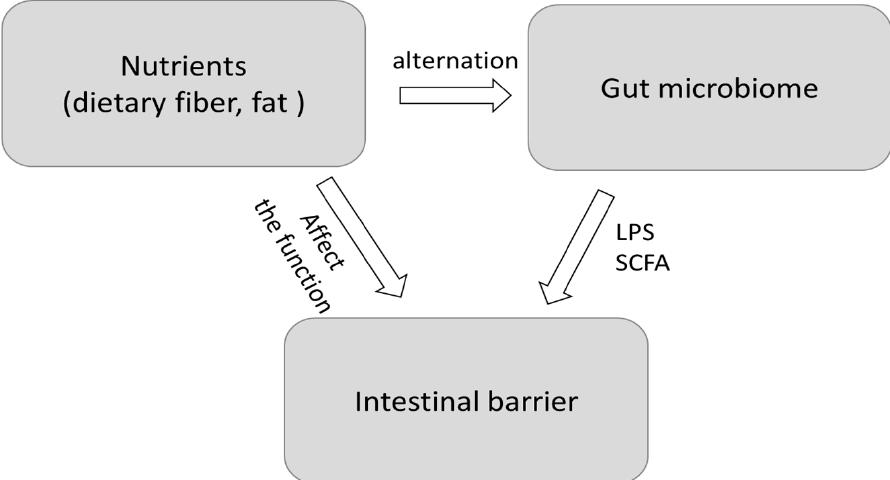
Figure 1. Relationships between nutrients, gut microbiome, and intestinal barrier. LPS: lipopolysac- charides, SCFAs: short-chain fatty acids.